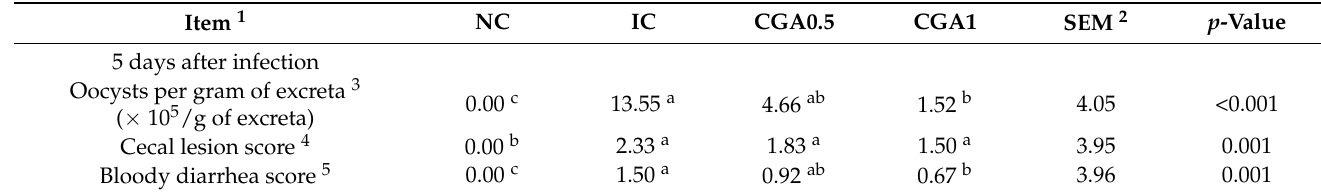
Table 3. Effects of chlorogenic acid (CGA) on the anticoccidial indicators of broilers ( n = 6).